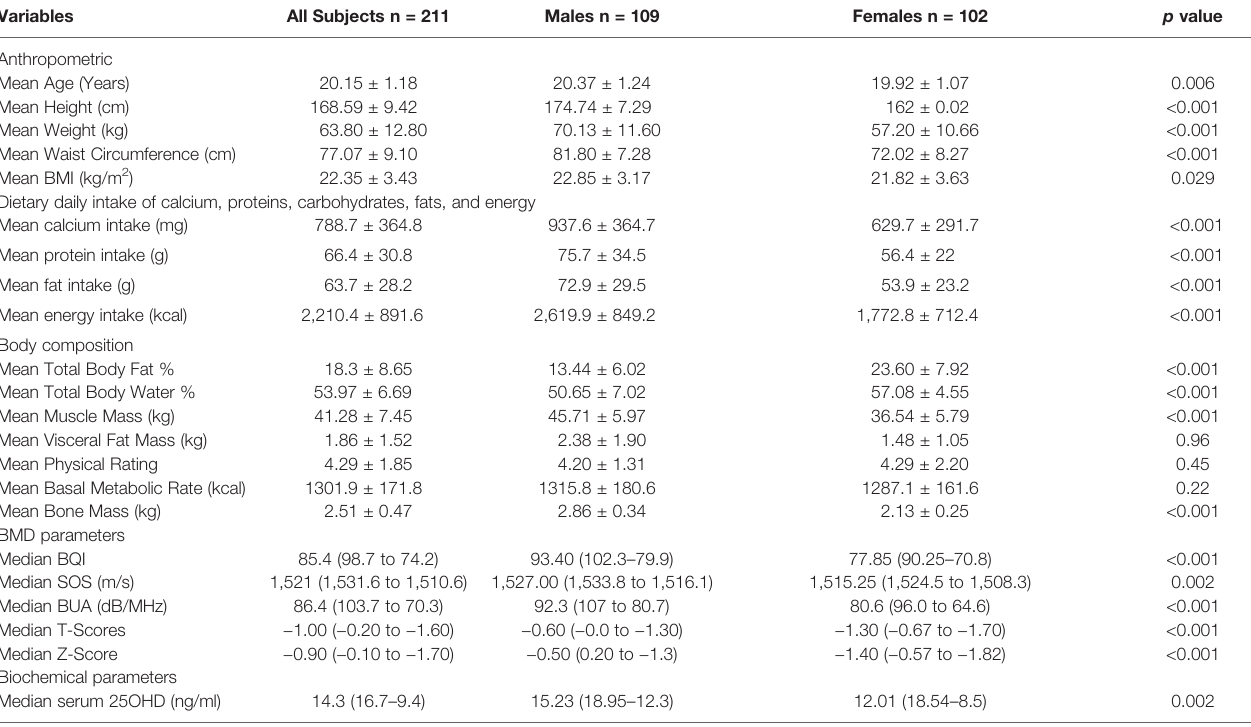
TABLE 1 | Body composition, dietary intake, lifestyle factors, and bone mineral density of medical students (n = 211).